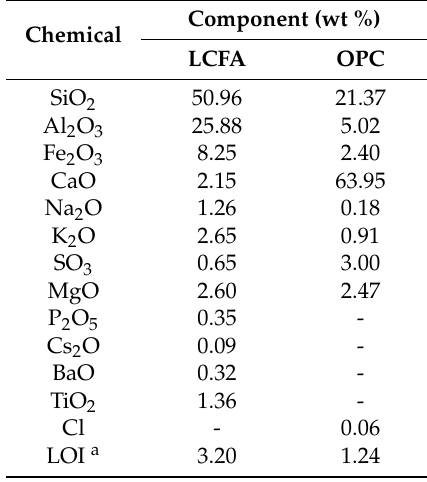
Table 2. Chemical composition of the LCFA and the OPC.